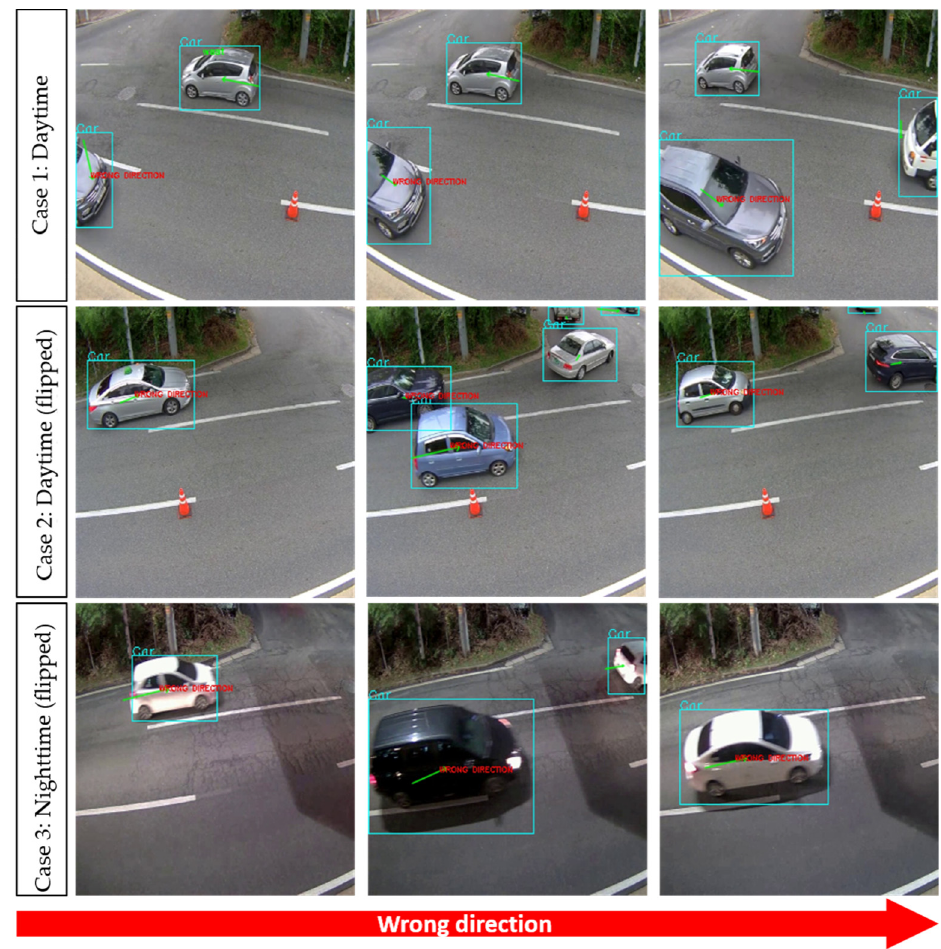
Figure 8. Wrong-direction detection for the three simulation cases.